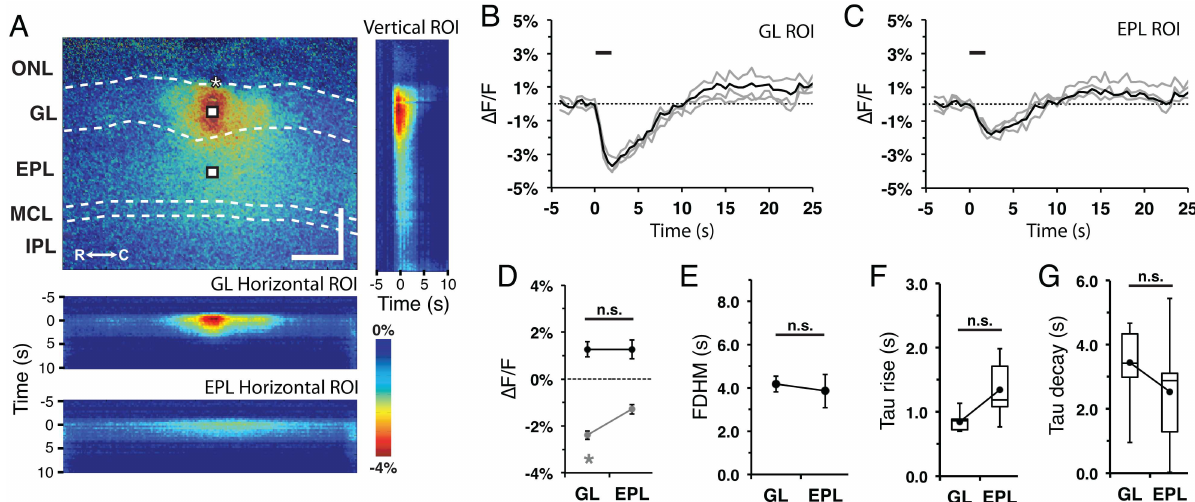
Fig 9. NAD(P)H signal profile in the glomerular and external plexiform layers. (A) (top) 10x magnification NAD(P)H image at 2.5 s post-stimulus initiation.ONL, olfactory nerve layer; GL, glomerular layer; EPL, external plexiformlayer; MCL, mitral cell layer; IPL, internal plexiform layer; GrL, granulecell layer; R, rostral; C, caudal.Asterisk, tip of the stimulatingelectrode. Targeted glomerulus indicatedby dashedcircle. (right) Vertical ROI heat map across the MOB layers exhibitstimulus-dependent,trans-laminarspread over time. (bottom) HorizontalROI heat maps from the GL and EPL exhibitstimulus dependentlateral spreadover time. Scale bar = 150 μ m. (B and C) Representative ROI individual (gray) and mean (black) traces from the activated glomerulus(B) and EPL area (C), indicatedin (A). Line: stimulus train delivery and duration. (D) Mean signal amplitudeof the initial dip (F (11,1) = 57.0, p < 0.001)and overshoot betweenthe GL and EPL areas. (E) Mean FDHM durationbetweenthe GL and EPL. (F and G) NAD(P)H signal time-to-peak (F) and time-to-trough (G) between the GL and